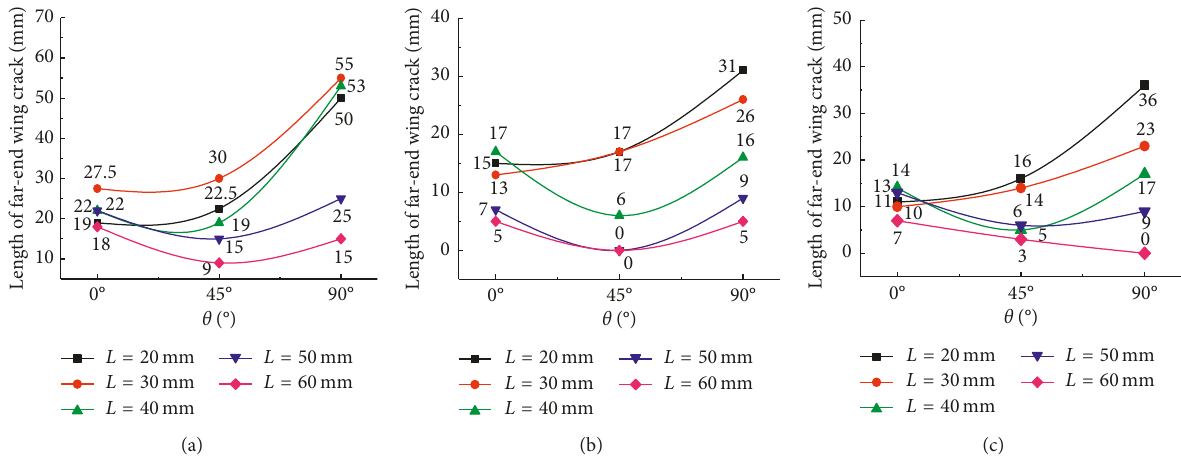
Figure 8: Relationship between θ and length of the far-end wing crack. (a) Air; (b) soil; (c) water.